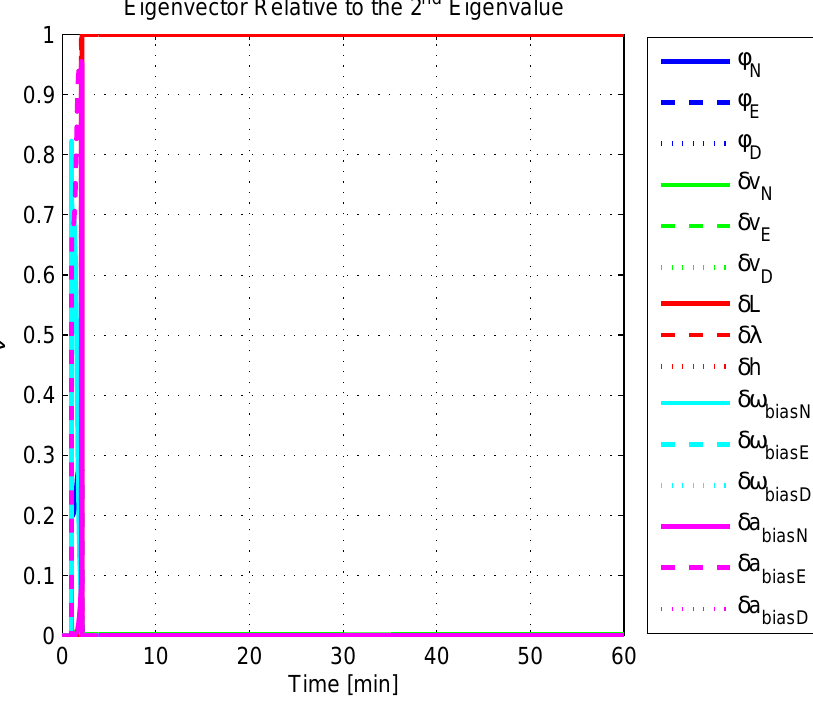
Figure 17. Eigenvector relative to the second eigenvalue in the experimental